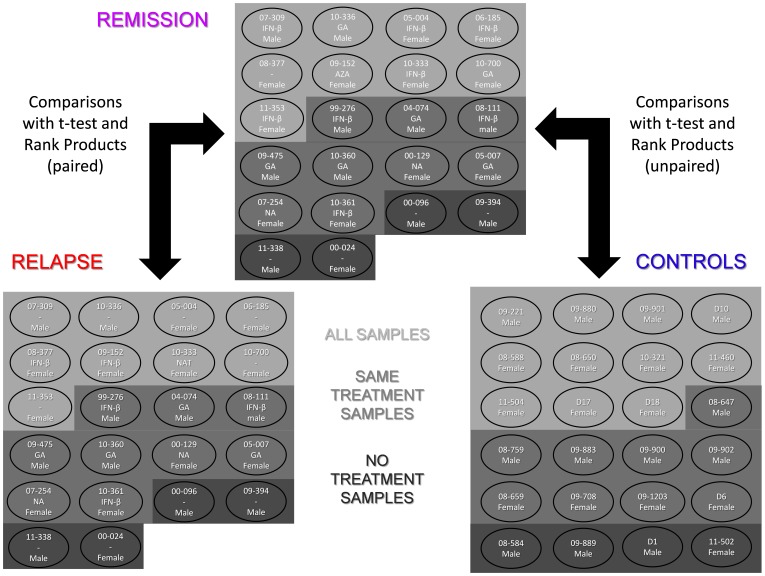
Distribution of samples across the subgroups made based on treatment, sex and condition.The code, sex and treatment-state are displayed for each subject (treatment is not displayed for controls). SAME TREATMENT SAMPLES: samples of patients with the same treatment state in relapse and remission and matched controls; NO TREATMENT SAMPLES: samples of patients with no treatment in relapse and remission and matched controls; AZA: azathioprine; GA: glatiramer acetate; IFN-β: interferon β; NA: natalizumab.